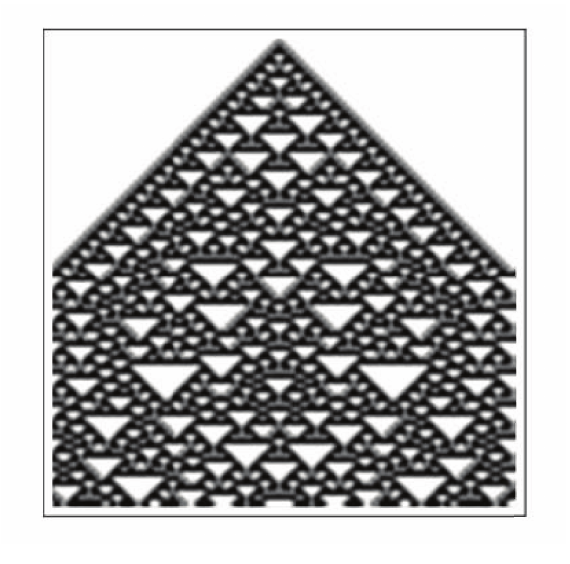
Figure 5. Eating behavior influenced by neighbors according to (37), radius r = 1, three states (k = 3): 0 = normal = white, 1 = overweight = grey, 2 = obese = black. Assuming a totalistic rule gives the cellular automaton rule #471. Simulations are for 100 agents (circular) and 100 time steps initiated by a single